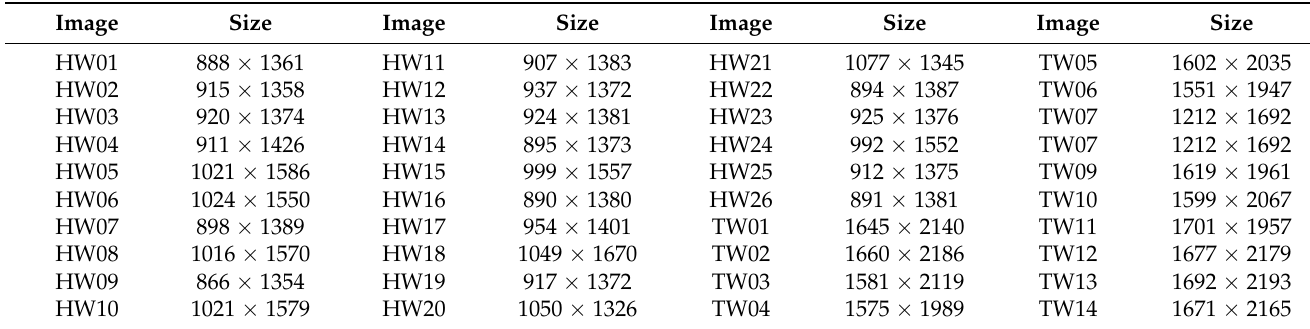
Table 3. Size of the test images in